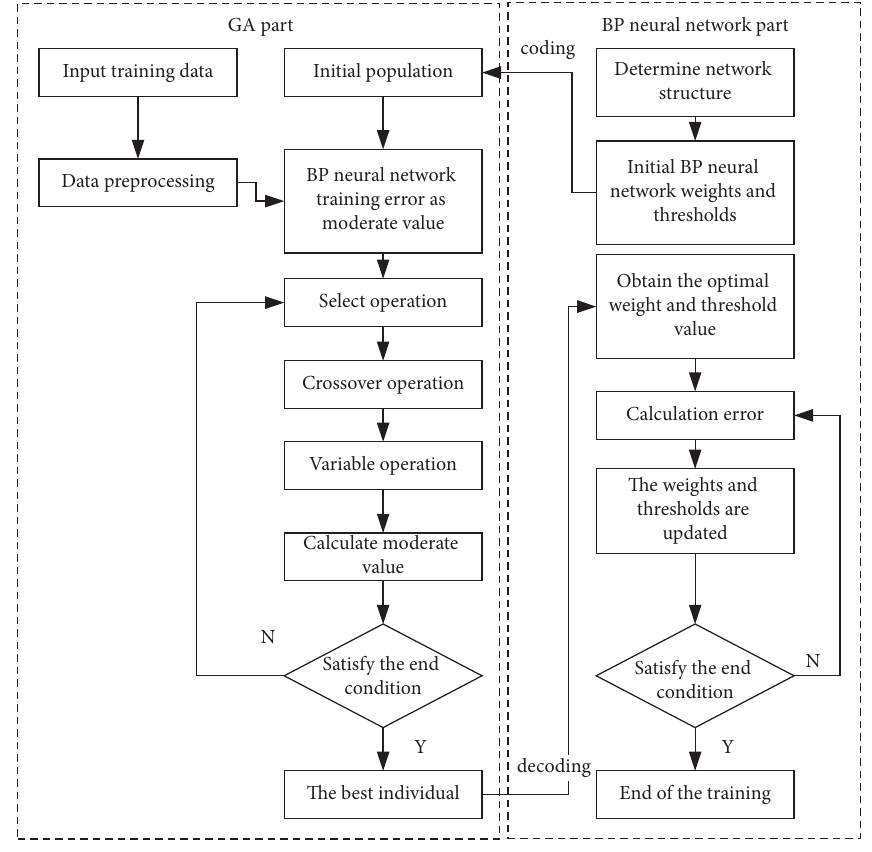
Figure 4: Optimization of the BP neural network by the genetic algorithm